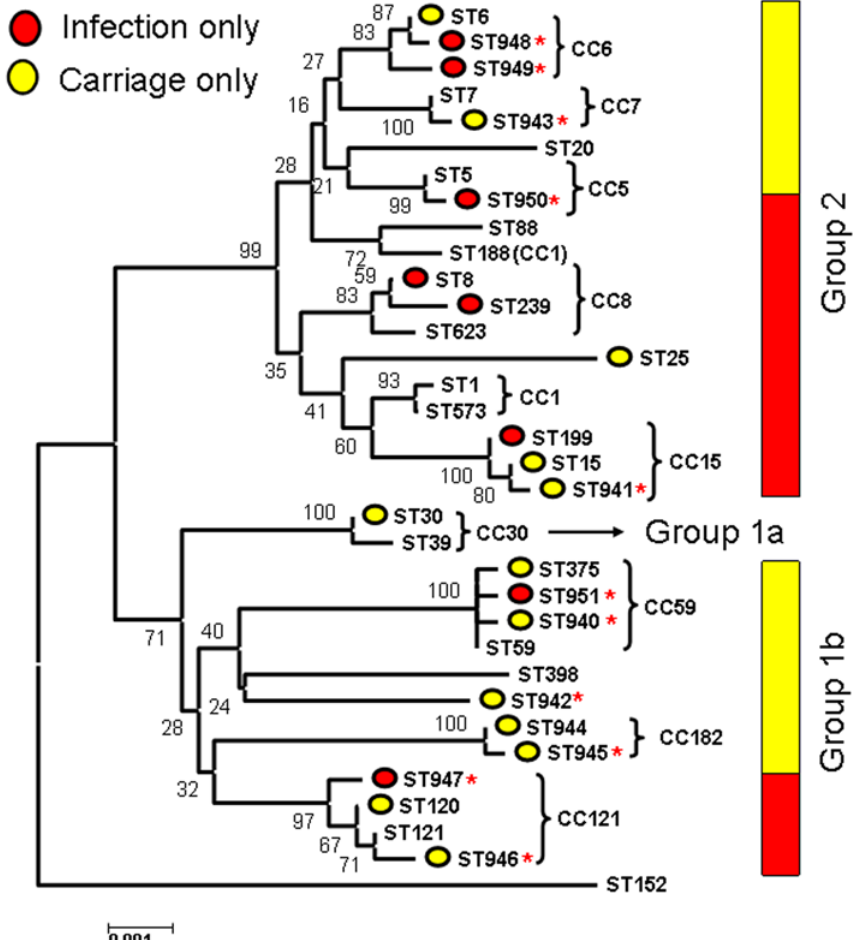
Figure 6. A neighbour-joining tree based on the concatenated sequences of each of the 32 sequence types noted in the combined dataset, as implemented in Mega v4.0 [ 46 ] using Kimura-2-parameter distances. Bootstrap support (based on 1,000 replicates) are given on the nodes. The most basal nodes are reasonably well supported and correspond to the delineation of the three major groups (1a, 1b and 2) identified previously [35]. The grouping of STs into CCs (terminal clusters) is shown by curly brackets. Note the inconsistent position of ST188 (Group 2; CC1), which is a DLV of ST1 but clusters with ST88 on the basis of allele sequences due to recombination. STs which were only noted in the disease sample are marked by a red circle, whilst STs only noted in the carriage sample are marked by a yellow circle. STs common to both datasets are not marked with a circle. Novel STs (first noted in the current study) are marked by a red asterisk. The proportion of isolates corresponding to the disease and carriage datasets are shown by red and yellow bars for Groups 2 and 1b. There is a significantly higher proportion of disease isolates within Group